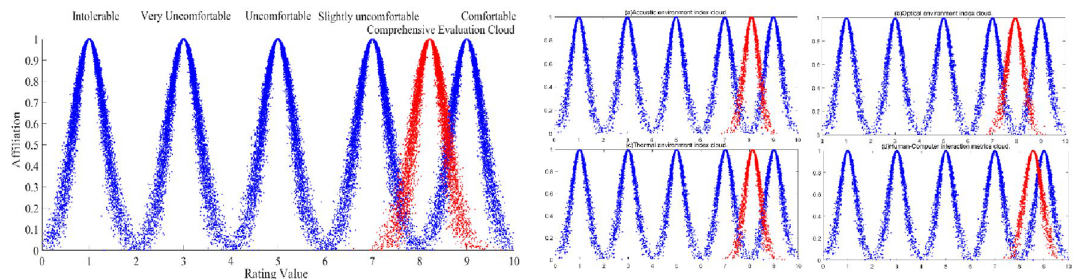
Fig. 3a. Through the forward cloud generator and inverse cloud generator proposed by Chinese academician Li De-Yi in 1995 46 , the comprehensive evaluation cloud map of the intelligent automobile cockpit comfort and the